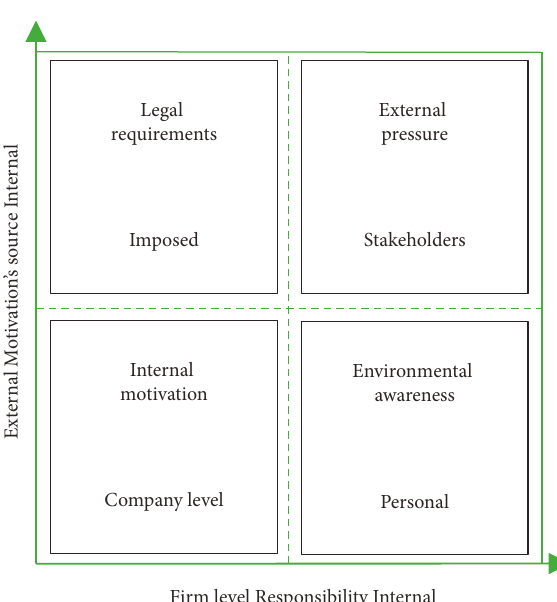
Figure 1: GSCM drivers’ grouping